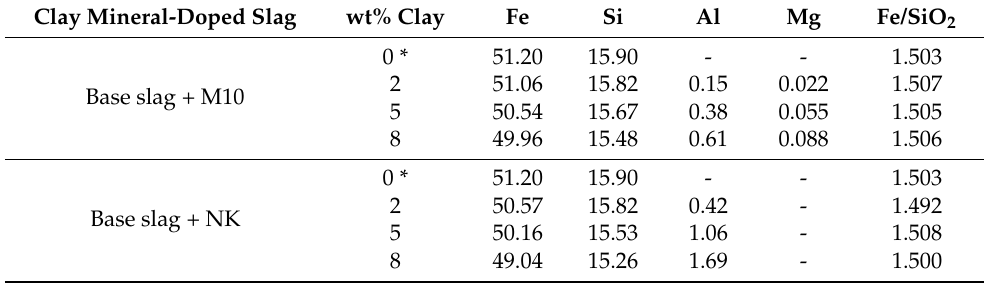
Table 2. Calculated compositions of the doped slags loaded for the main experiments. Clay Mineral-Doped